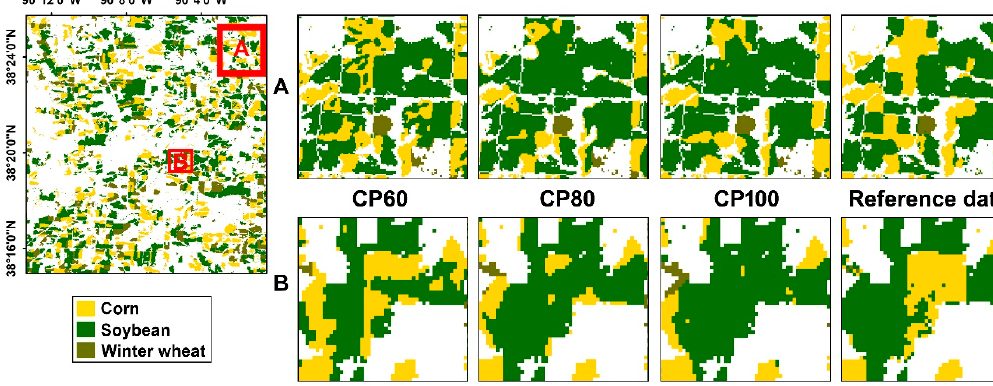
Figure 9. Classification results with respect to different class purity values when using a 9 by 9 patch in Illinois. Two subareas denoted as A and B are zoomed out for comparison purposes.